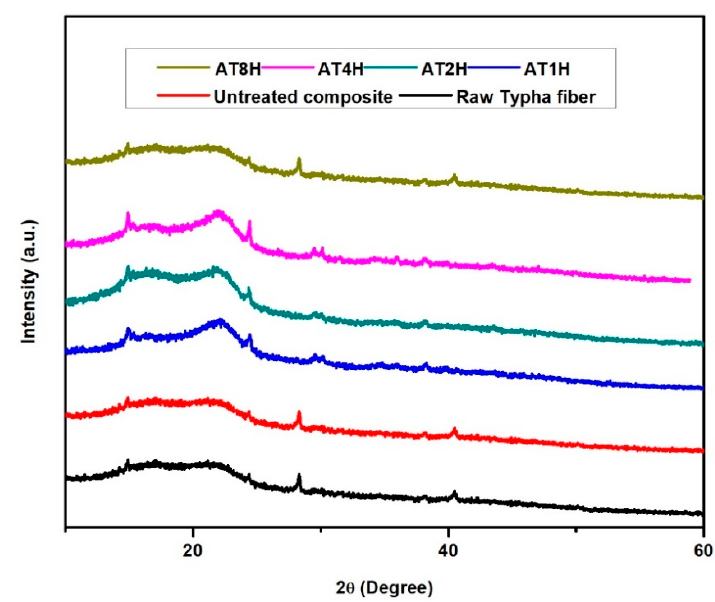
Figure 2. X-ray Diffraction patterns of raw Typha fiber, untreated and treated Typha fiber reinforced epoxy composites.